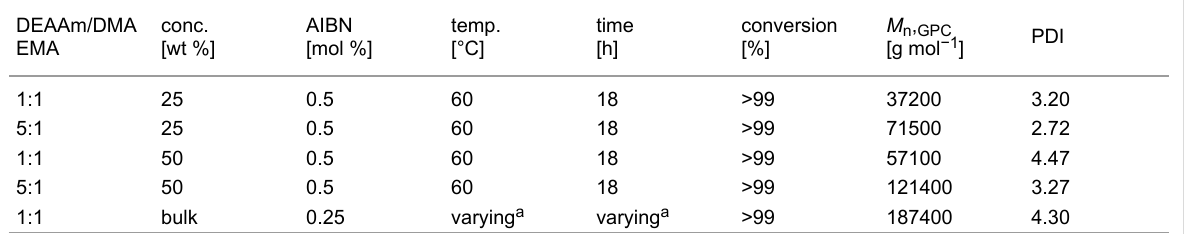
Table 1: Results for the copolymerization of DEAAm and DMAEMA using different monomer ratios. DEAAm/DMA